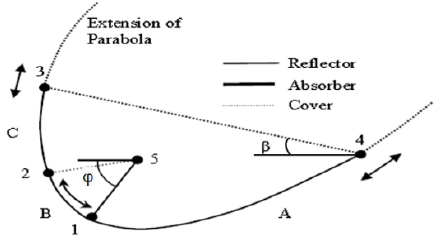
Figure 2. Basic structure of Maximum Reflector Collector (MaReCo) [23].